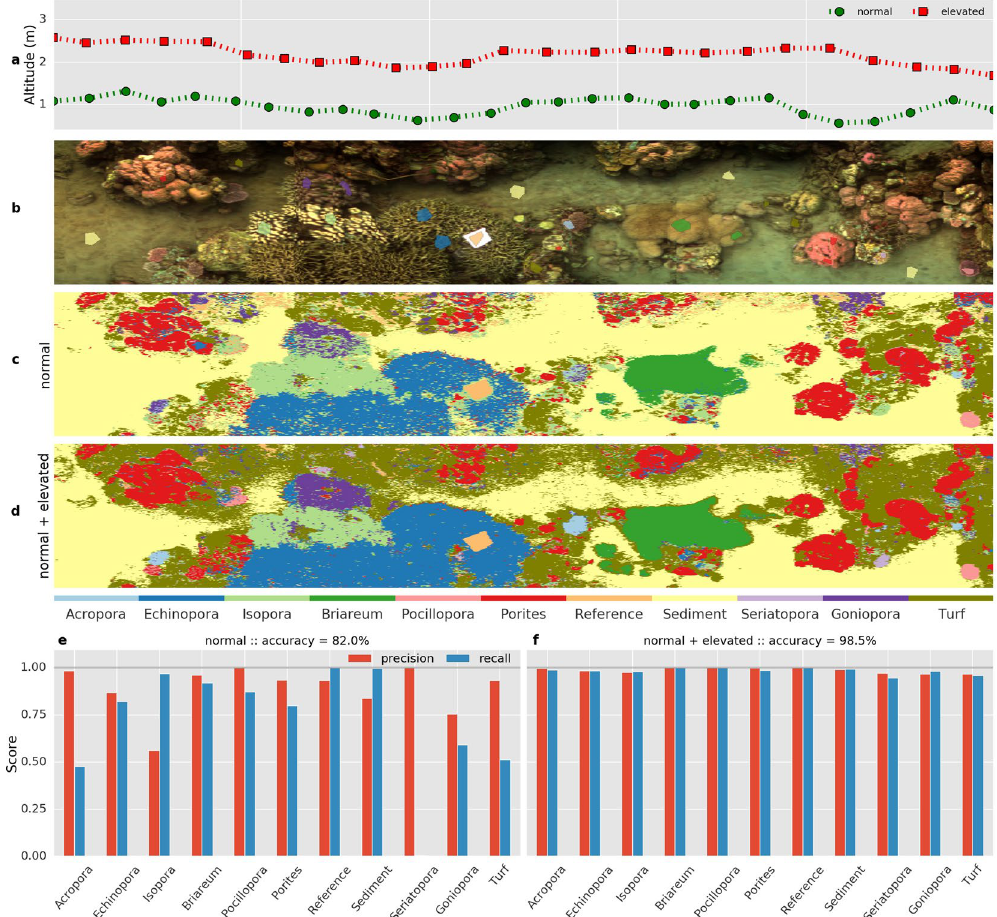
Fig. 4a, and the elevated altitude image in panel (b). Multi-layer perceptron classifiers were used to create classified benthic maps of the elevated altitude image. The map in panel (c) was created by a classifier trained on the annotated pixels from the normal altitude image only, whereas the map in panel d was created from a classifier trained on annotated pixels in both altitude images (panel b and Fig. 4a). The performance metrics for the two classifiers are shown in panels (e and f)